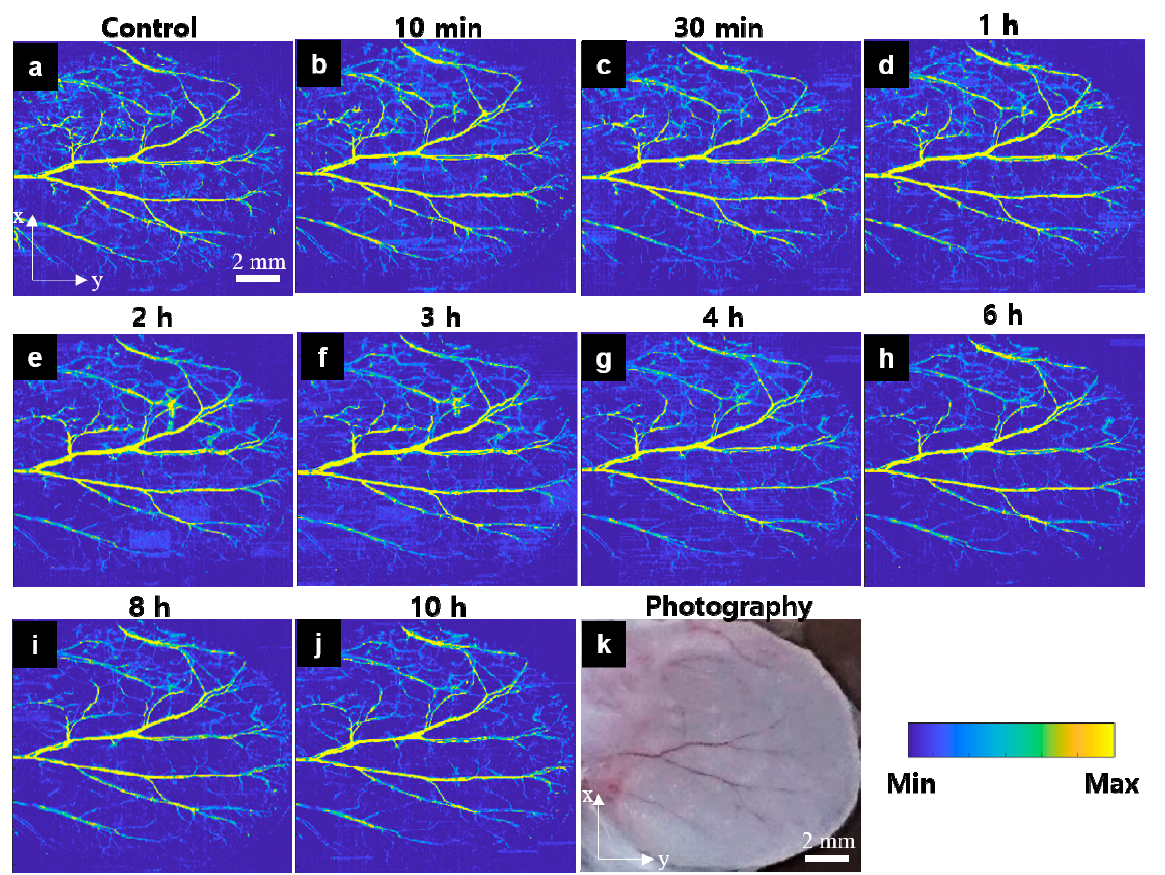
Figure 5. In vivo OR-PAM MAP images for the peripheral vasculatures of the mouse ear after PBS injection (Movie 3). ( a ) OR-PAM MAP image before PBS, ( b – j ) OR-PAM MAP images after PBS solution injection within 10 h, and ( k ) Photograph of the corresponding mouse ear.